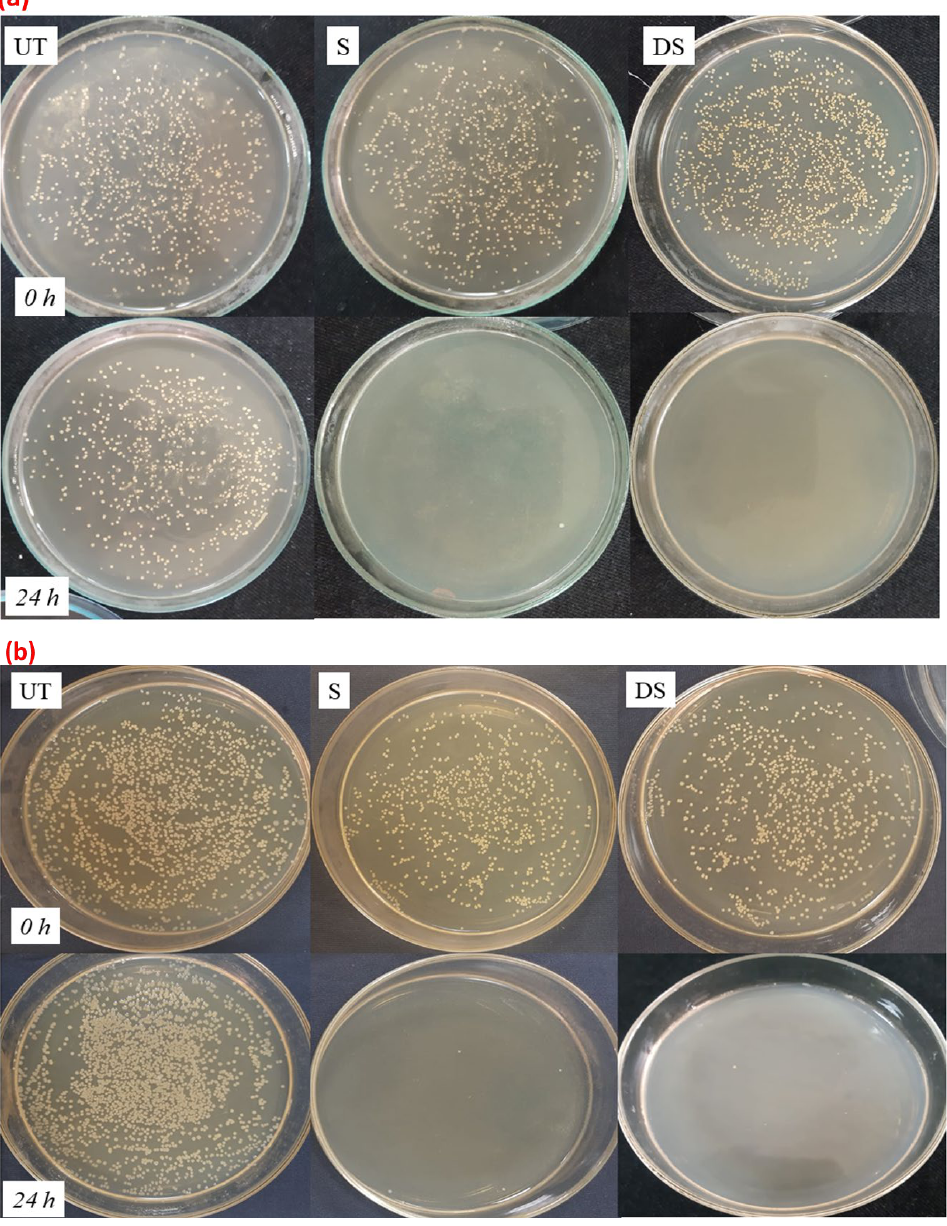
Figure 12. ( a ): images for the number of bacterial colonies that were inoculated (0 h) and survived (24 h) for samples UT, S, and DS against S. aureus. ( b ): images for the number of bacterial colonies that were inoculated (0 h) and survived (24 h) for samples UT, S, and DS against E. coli.